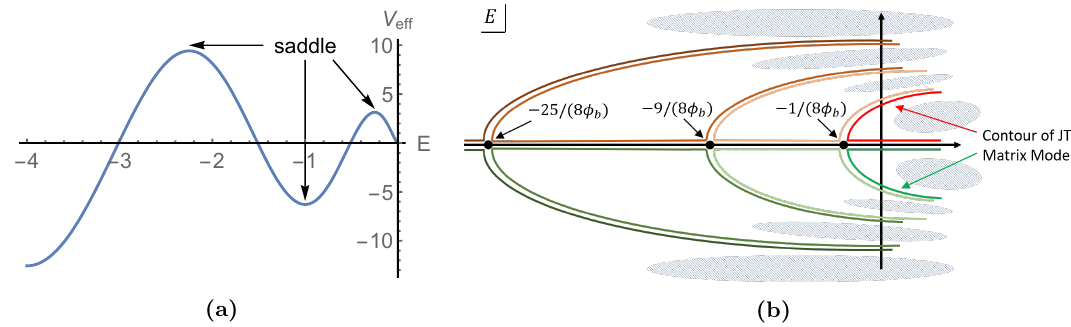
Figure 9. (a) The effective potential of SSS potential for E < 0 where the first saddle is at E saddle = − 1 / (8 φ b ) . (b) First a few basis γ i (that are infinite many) on complex E plane for the matrix model dual to JT gravity. Here we use different colors to distinguish independent basis. Along each γ i to infinity < V eff → + ∞ (except being constant along positive real axis D ρ along the shaded regions between contours < V eff → −∞ . To have the spectrum ρ JT ( E ) starting at origin, we must choose the defining contour Γ i for every eigenvalue λ i on one of the rightmost two contours that are labeled by bright red and green